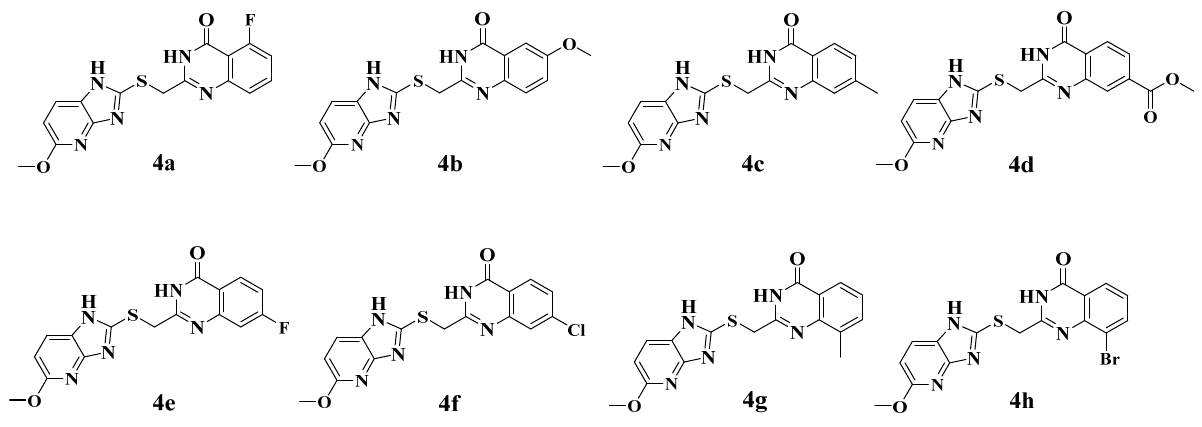
Figure 4. The chemical structures of eight candidate compounds. Table 1. The -CDOCKER_ ENERGY values of eight candidate compounds.